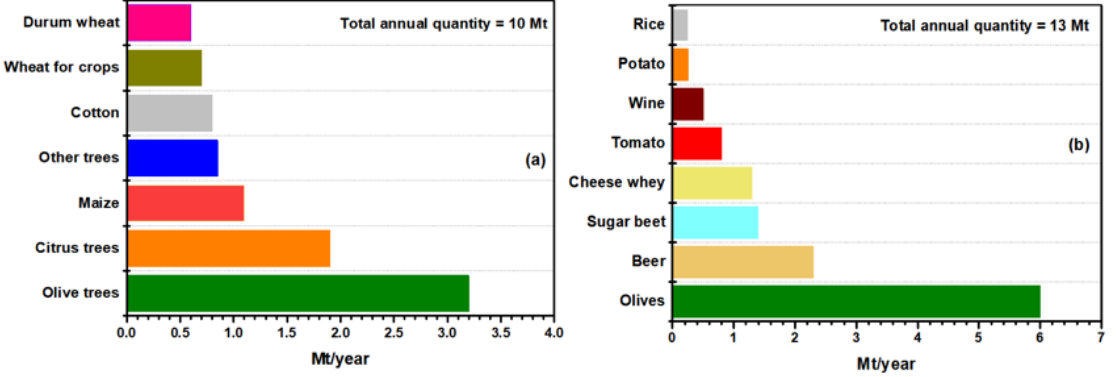
Figure 1. Agricultural ( a ) and agro-industrial ( b ) residues capacity in Greece.